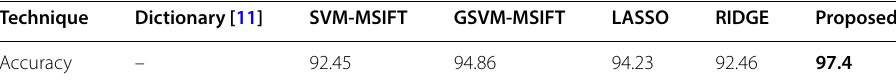
Table 8 Accuracy for different classifiers worked on FERET database Technique